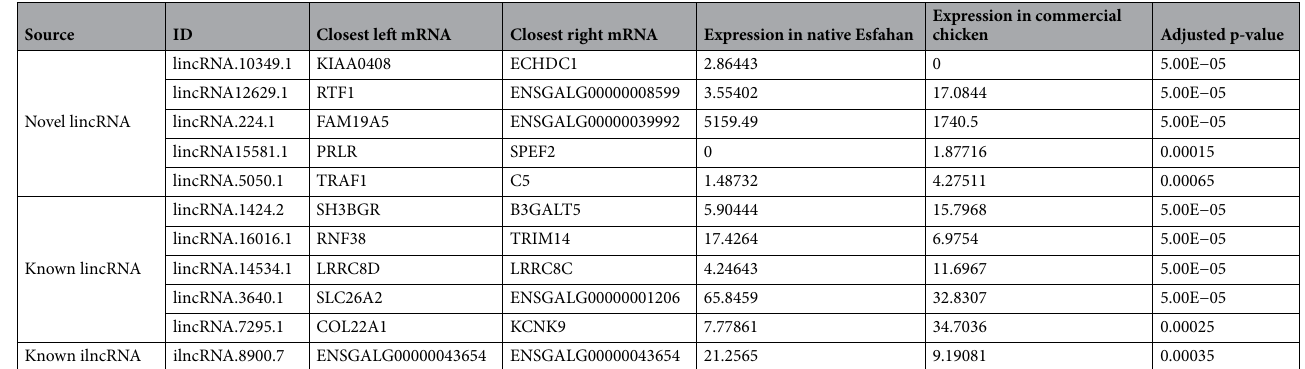
Table 2. The top five differentially expressed genes lncRNAs classes between the two breeds and their cis target gene.